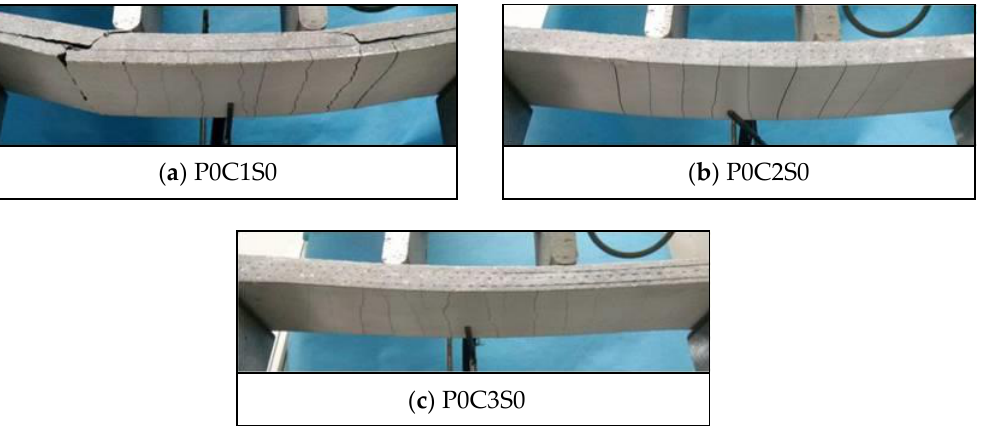
Figure 8. First-crack and ultimate stresses of the TRC specimens with different number of textile layers and addition of 1% volume content of steel fibres. Polymers 2018 , 10, x FOR PEER REVIEW